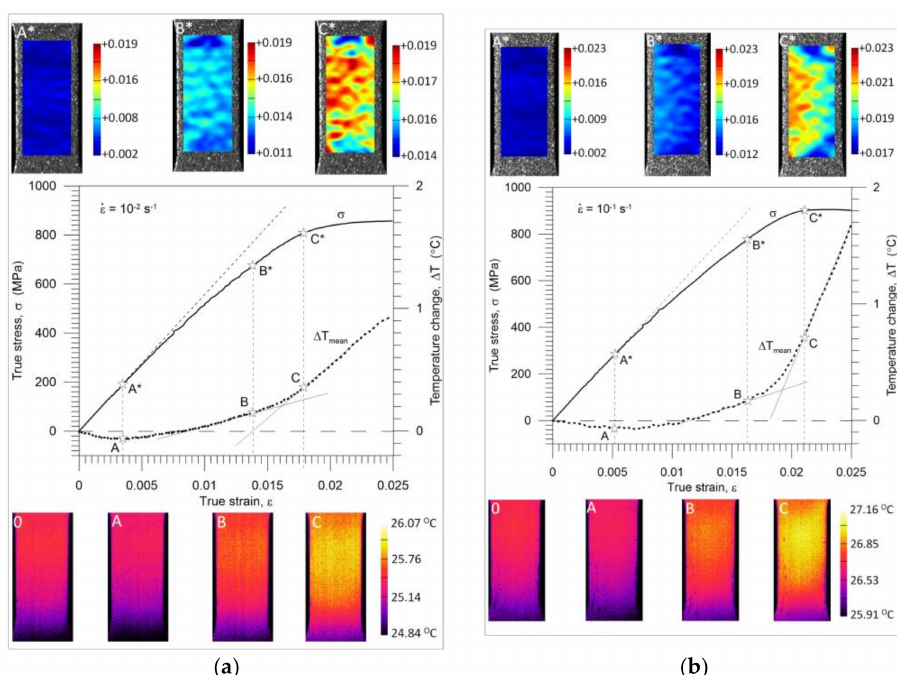
Figure 6. Stress σ and temperature change ∆ T mean versus strain ε for Gum Metal’s tension in the initial deformation range at strain rates of ( a ) 10 − 2 s − 1 and ( b ) 10 − 1 s − 1 with strain distributions (above; A*-C*) and thermograms (below; 0, A-C).